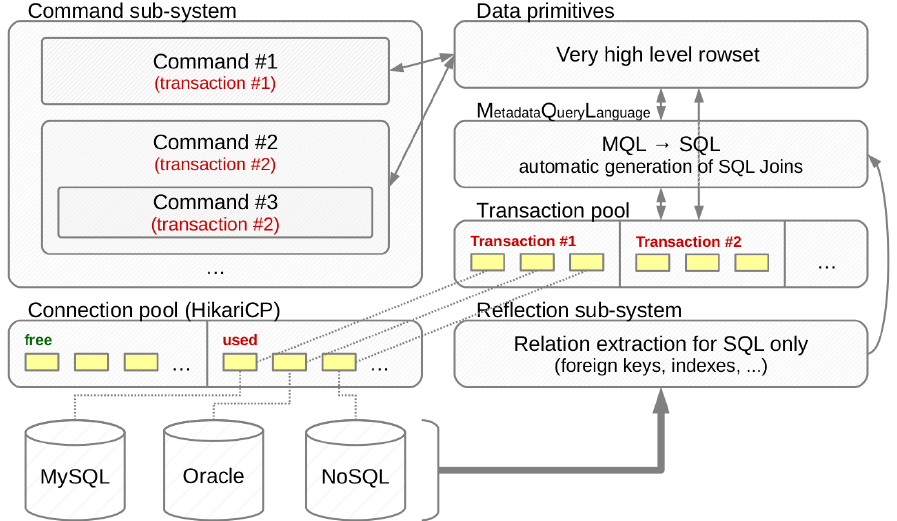
Fig. 3. Overview of the “metadata” layer with: the connection pool; the transaction pool; the reflection sub-system; the Metadata Query Language (MQL) and the “data primitives” sub-system. Fig. 4. Overview of the “command” layer. An AMI command is a java class, inheriting from net.hep.ami.command.AbstractCommand , and benefiting from the AMI “metadata” layer.